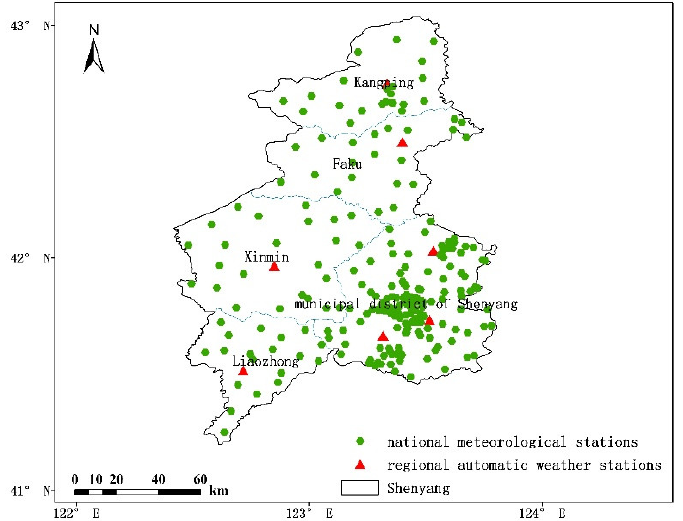
Figure 1. The spatial distribution of national meteorological stations and regional automatic weather stations in Shenyang.